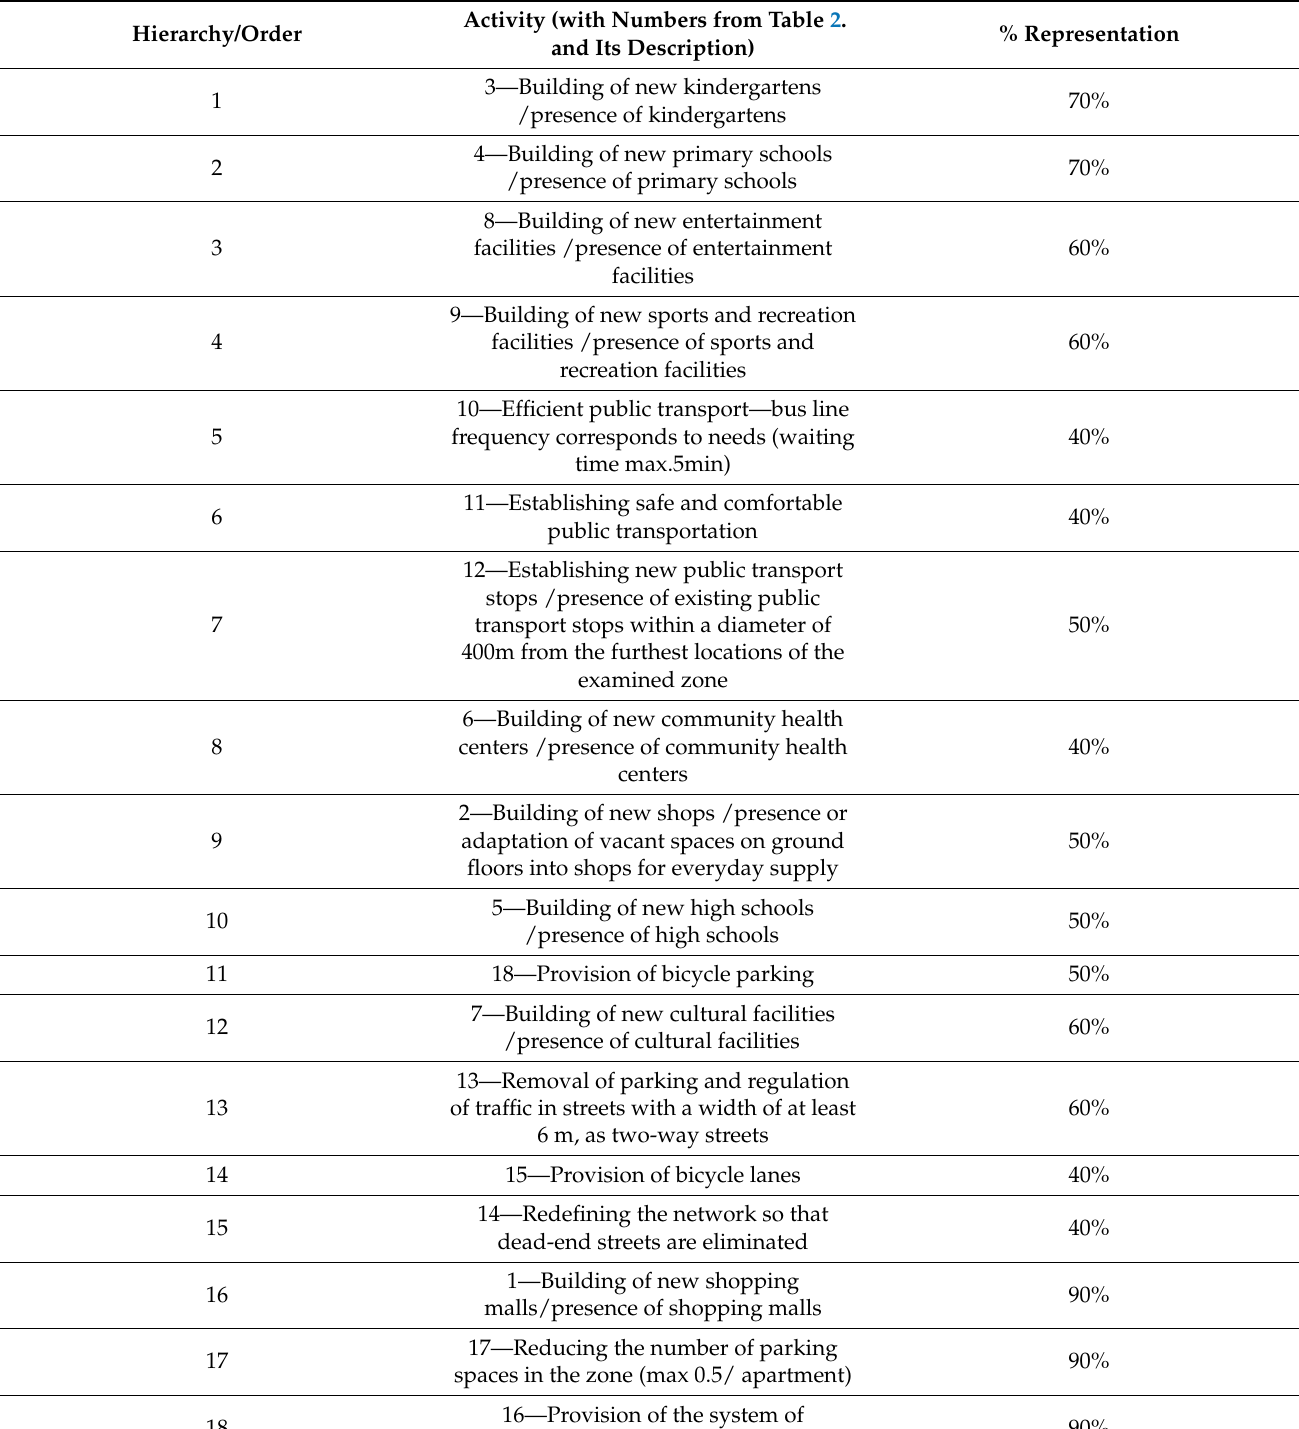
Table 3. Hierarchy proposal.